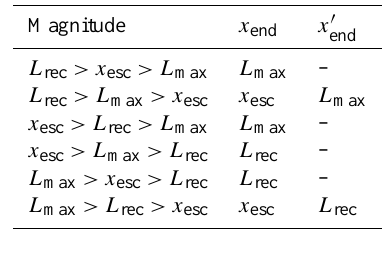
Figure 5. Illustration of the integration paths (red dotted lines) for an arbitrary wind direction for the two receptors in the canyon. The upper blue dotted line marks a critical wind direction ( θ l ) which affects the calculation of the integration path length, and L b is the length to the end of the canyon used to calculate the maximum in- tegration length ( L max ). L rec is the length of the recirculation zone. A second recirculation zone is illustrated in blue with the new inte- gration lengths likewise plotted with dotted blue lines. Table 3. Table of upper integration limits for respectively Eq. (3) ) . The definition and calculation of the ( x end ) and Eq. (5) ( x (cid:48) end lengths can be found in Table